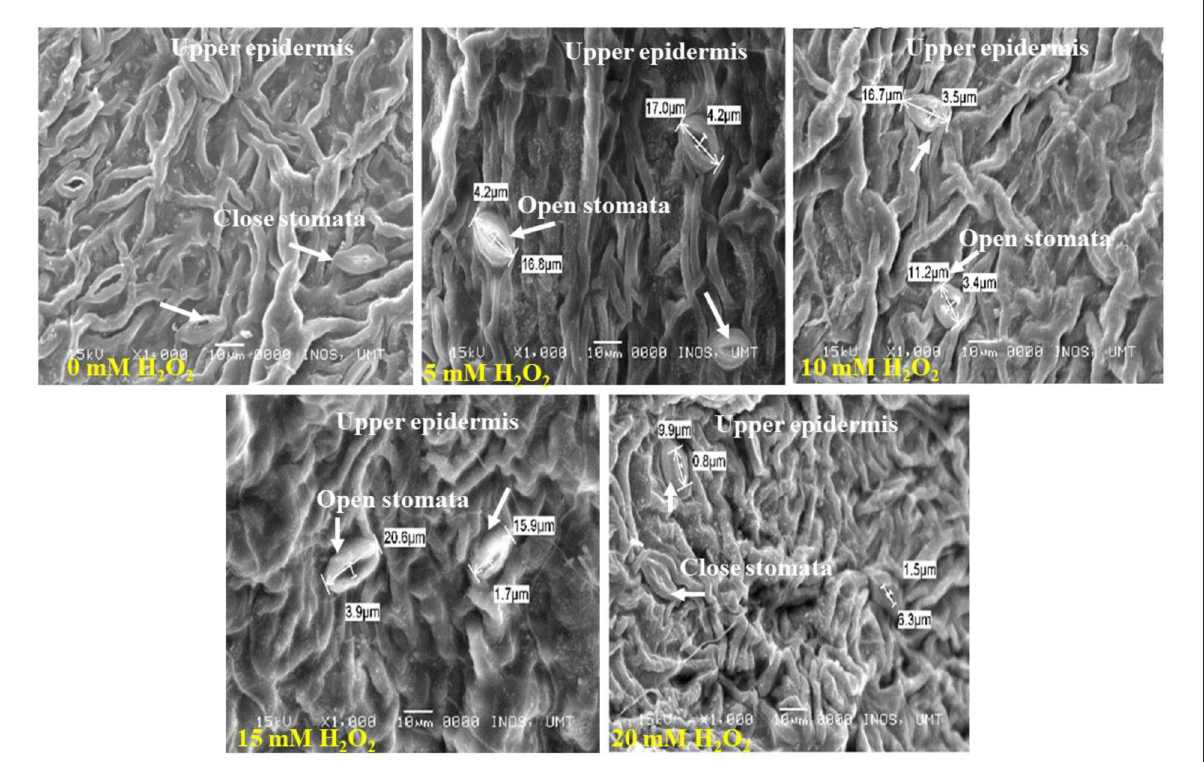
FIGURE3 SEM photographs of stomatal opening at leaf’s upper surface of H 2 O 2 treated and untreated plants. Stomata are closed at control treatment, but the stomatal opening or size increased with H 2 O 2 treatment (5 mM − 15mM H 2 O 2 ). Stomatal size starts to decrease again with a higher concentration of H 2 O 2 . Less number of stomata contained at the upper surface of the